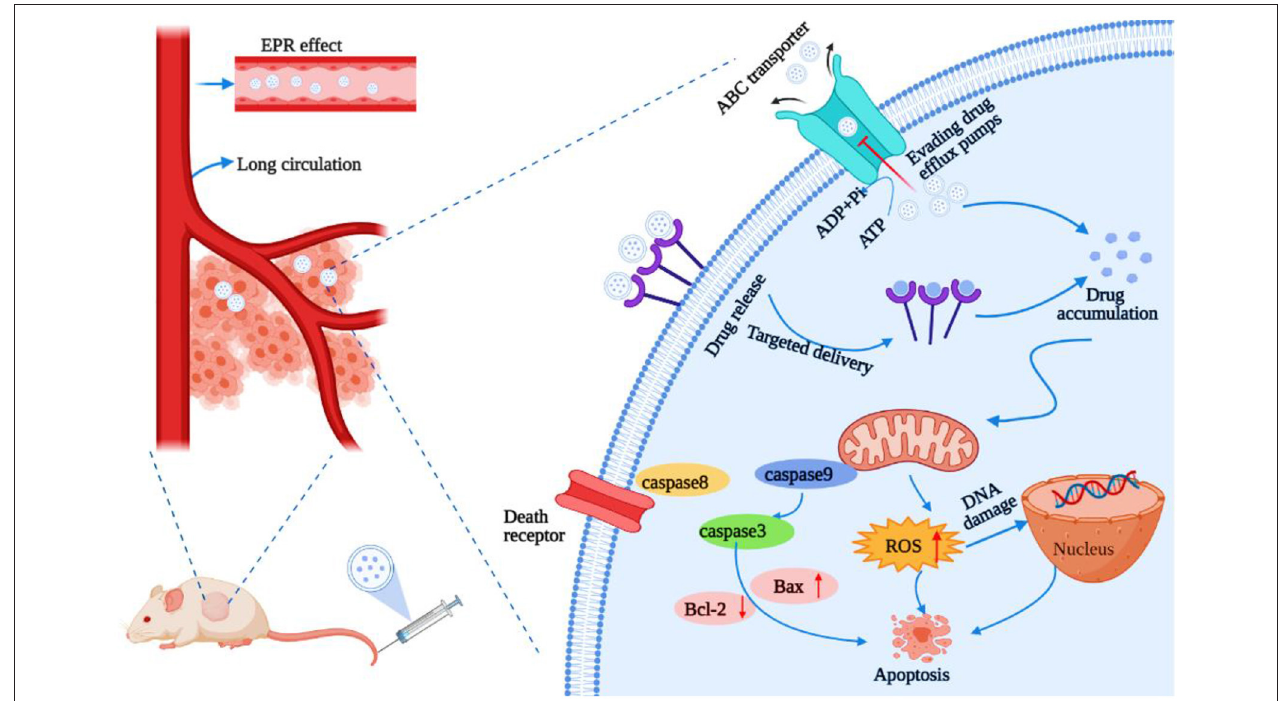
FIGURE 7 | Main role and mechanism of borneol modified nanoparticle-based drug delivery platforms for overcoming multidrug resistance (MDR). The figure was created by BioRender,